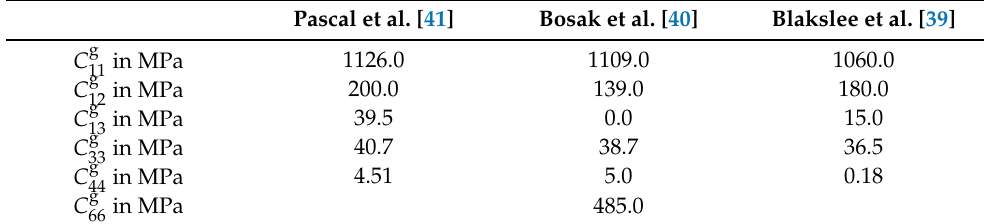
Table 3. Mechanical material parameters of the graphite lamellae. Pascal et al.